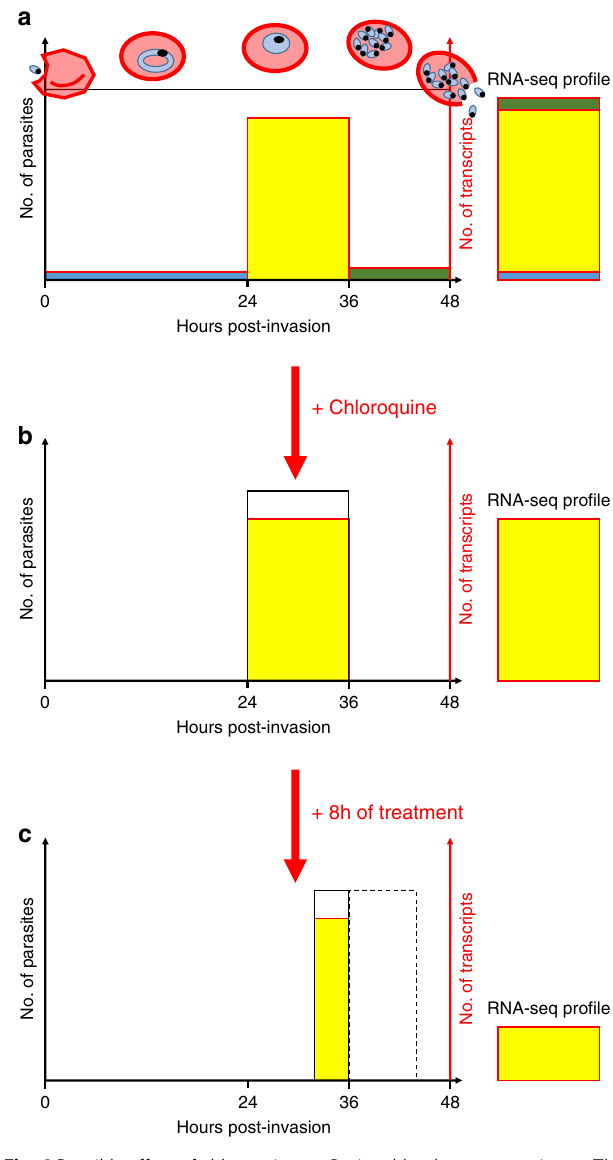
Fig. 4 Possible effect of chloroquine on P. vivax blood-stage parasites. a The fi gure shows a simpli fi ed P. vivax infection containing uniform amount of parasites (black line) along their intraerythrocytic cycle ( x -axis, in hours). The amount of mRNA produced by the different stages is represented in color (blue-rings, yellow-trophozoites, and green-schizonts) and well as the resulting RNA-seq pro fi le that is dominated by the transcriptionally active trophozoites (right). b Upon treatment with chloroquine, all rings and schizonts are killed while the trophozoites are not affected. c Eight hours after chloroquine treatment, there are no new trophozoites, since the rings have been eliminated, and the trophozoites developing into schizonts die (dashed box), producing much fewer P. vivax reads by RNA-seq,